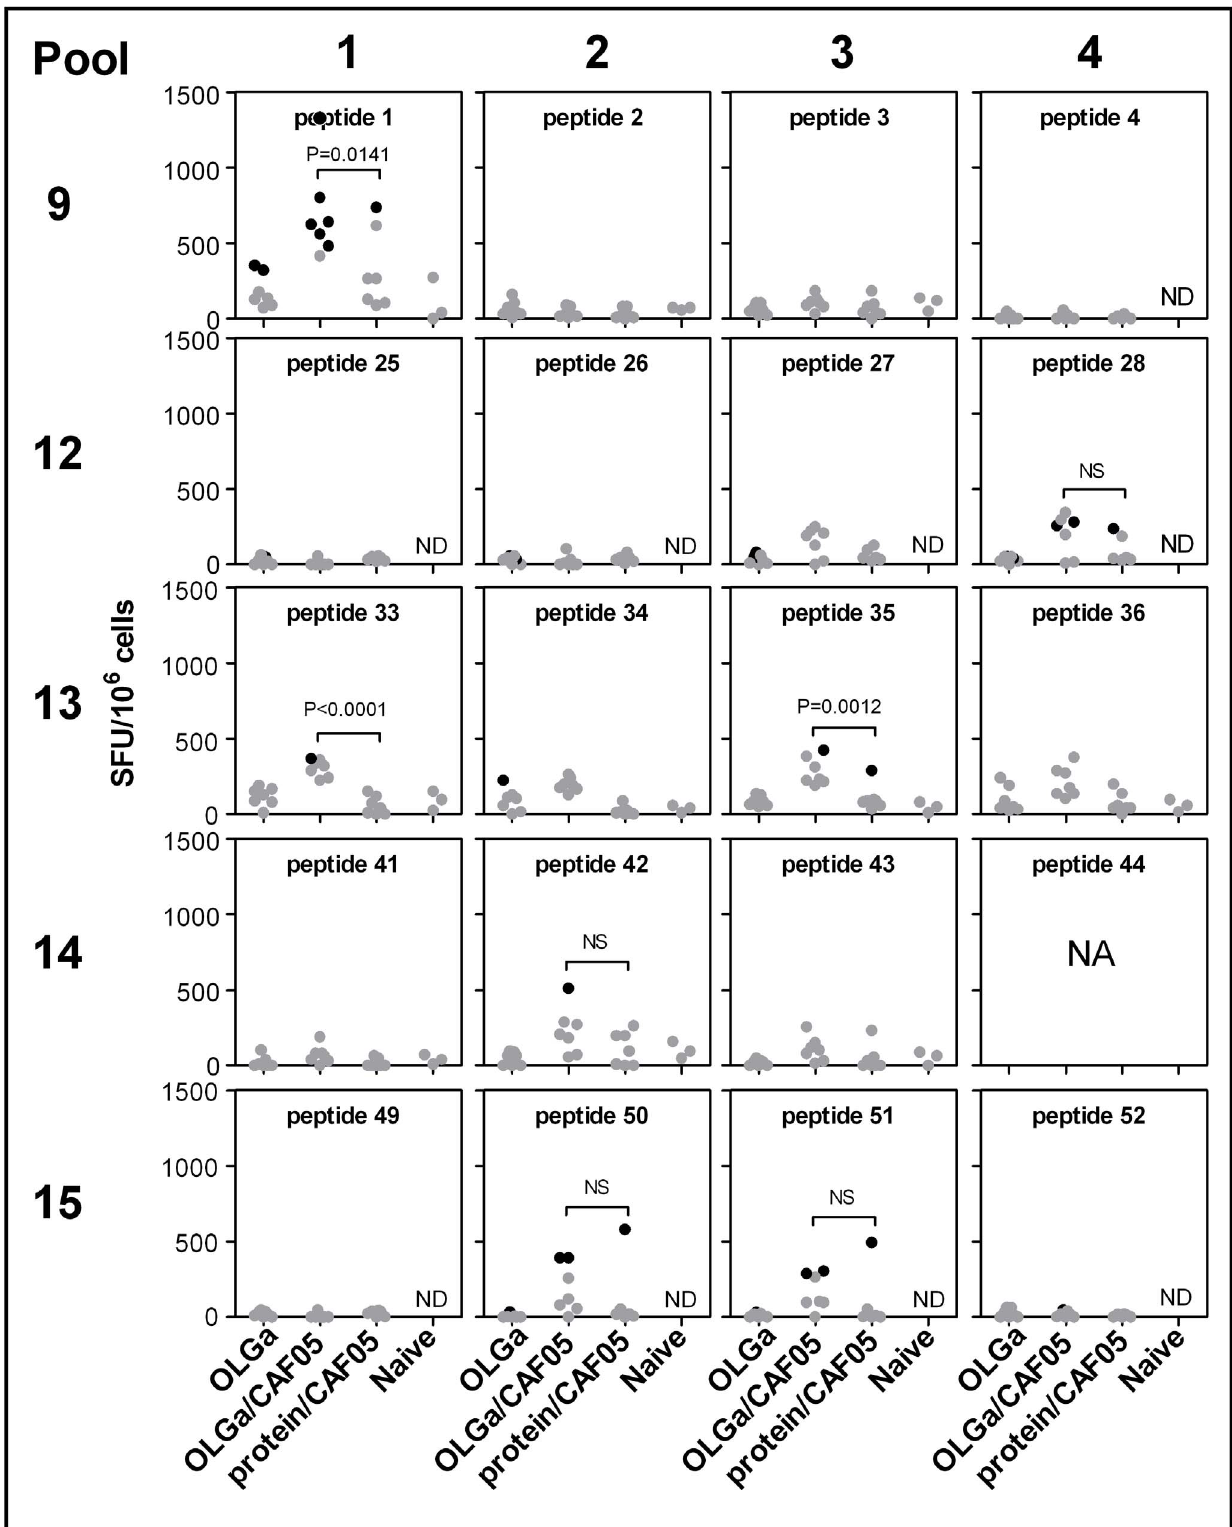
Figure 5. Stimulation of PBMCs with individual peptides selected based on positive peptide pools. HLA-A2/DR-transgenic mice were immunized three times with either the full set of overlapping peptides (OLGa, 2 m g/peptide) with or without CAF05 or protein (5 m g) in CAF05. Naı¨ve mice where used as the negative control. 10 days after the last immunization, splenocytes from individual mice were restimulated with the indicated peptides and the frequency of IFN- c -producing cells was determined by ELISPOT. Shown are values after background subtraction. Black symbols